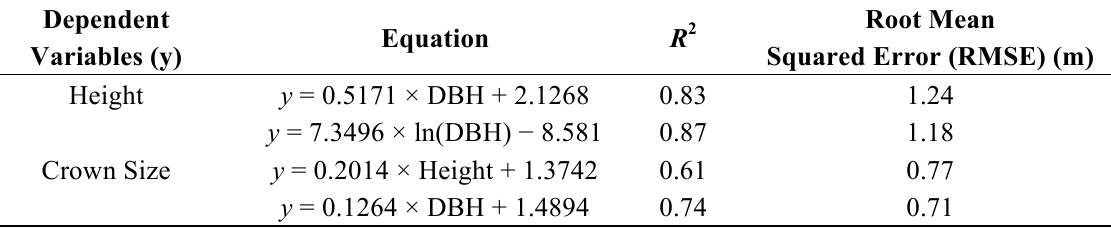
Table 1. Regression models of different ground-measured